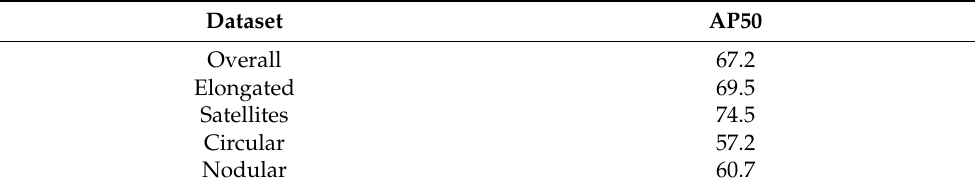
Table 7. Validation AP50 overall and on the different